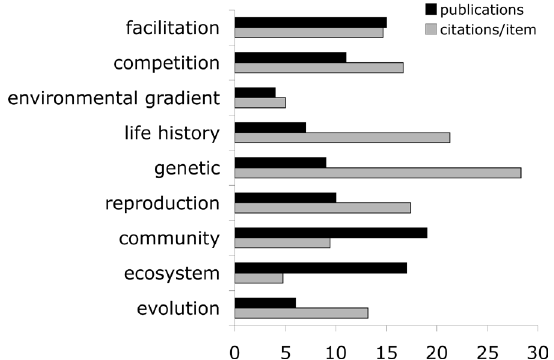
Figure 3. Number of publications and average number of ci- tations per publication from an ISI Web of Science search for ‘cushion plant’ and ‘facilitation’, ‘competition’, ‘environmental gradient’, ‘life history’, ‘genetic’, ‘reproduction’, ‘community’, ‘ecosystem’ and ‘evolution’,